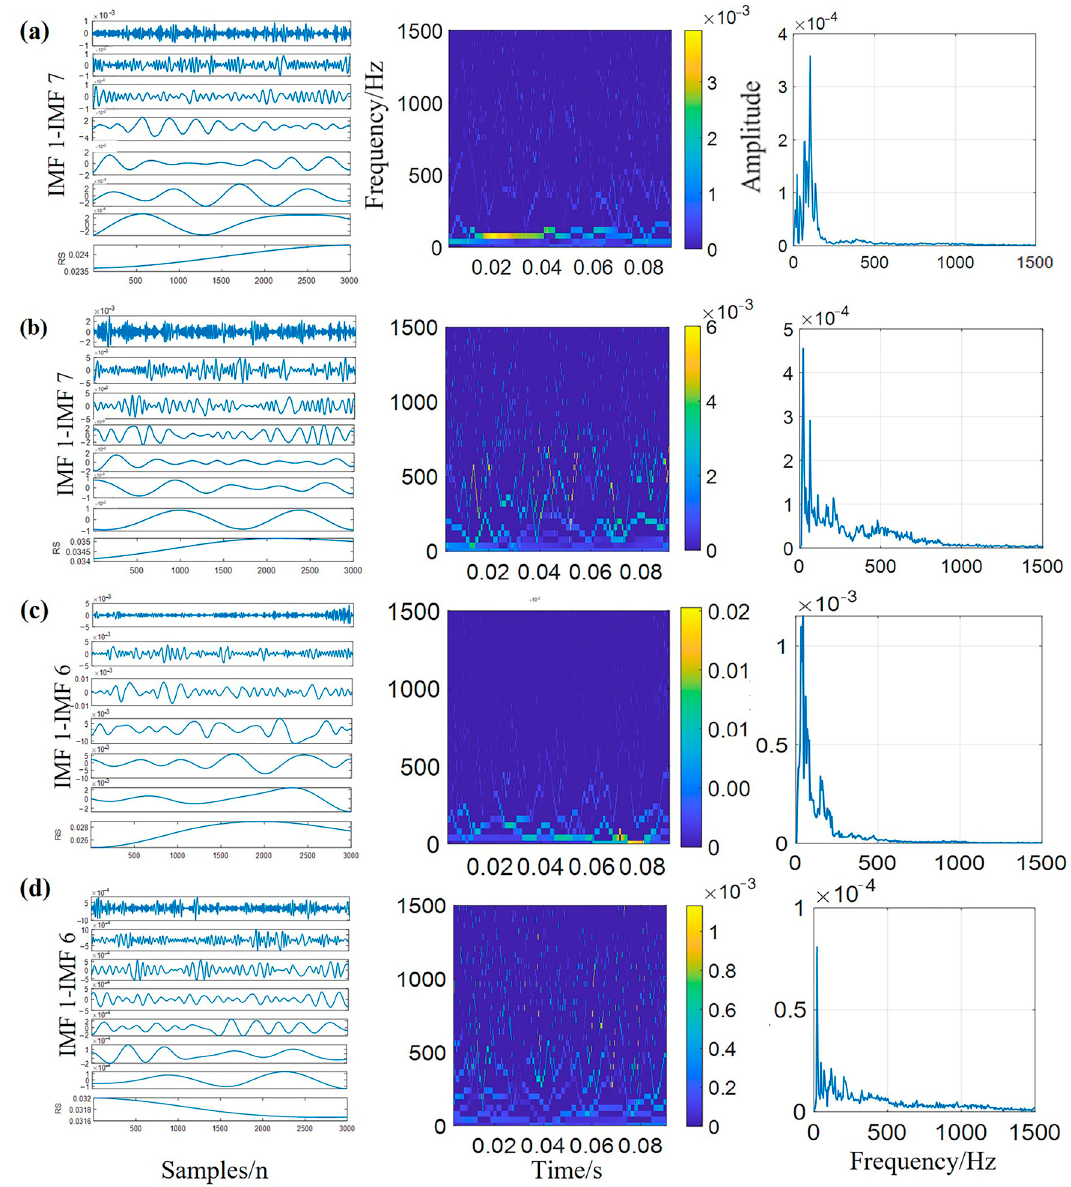
Figure 11. MEEMD decomposition results, Hilbert-Huang spectrum and marginal spectrum of four different types of ship samples: ( a ) cargo; ( b ) passenger ship; ( c ) tanker; ( d ) tug.